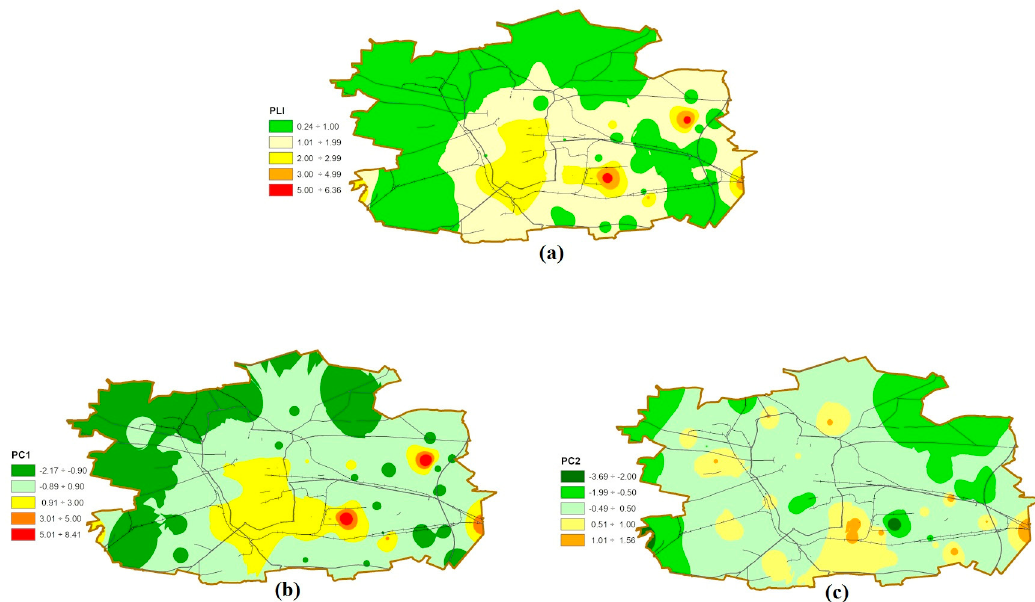
Figure 3. Spatial distribution of ( a ) pollution load index (PLI); ( b ) first principal component (PC1); ( c ) second principal component (PC2).